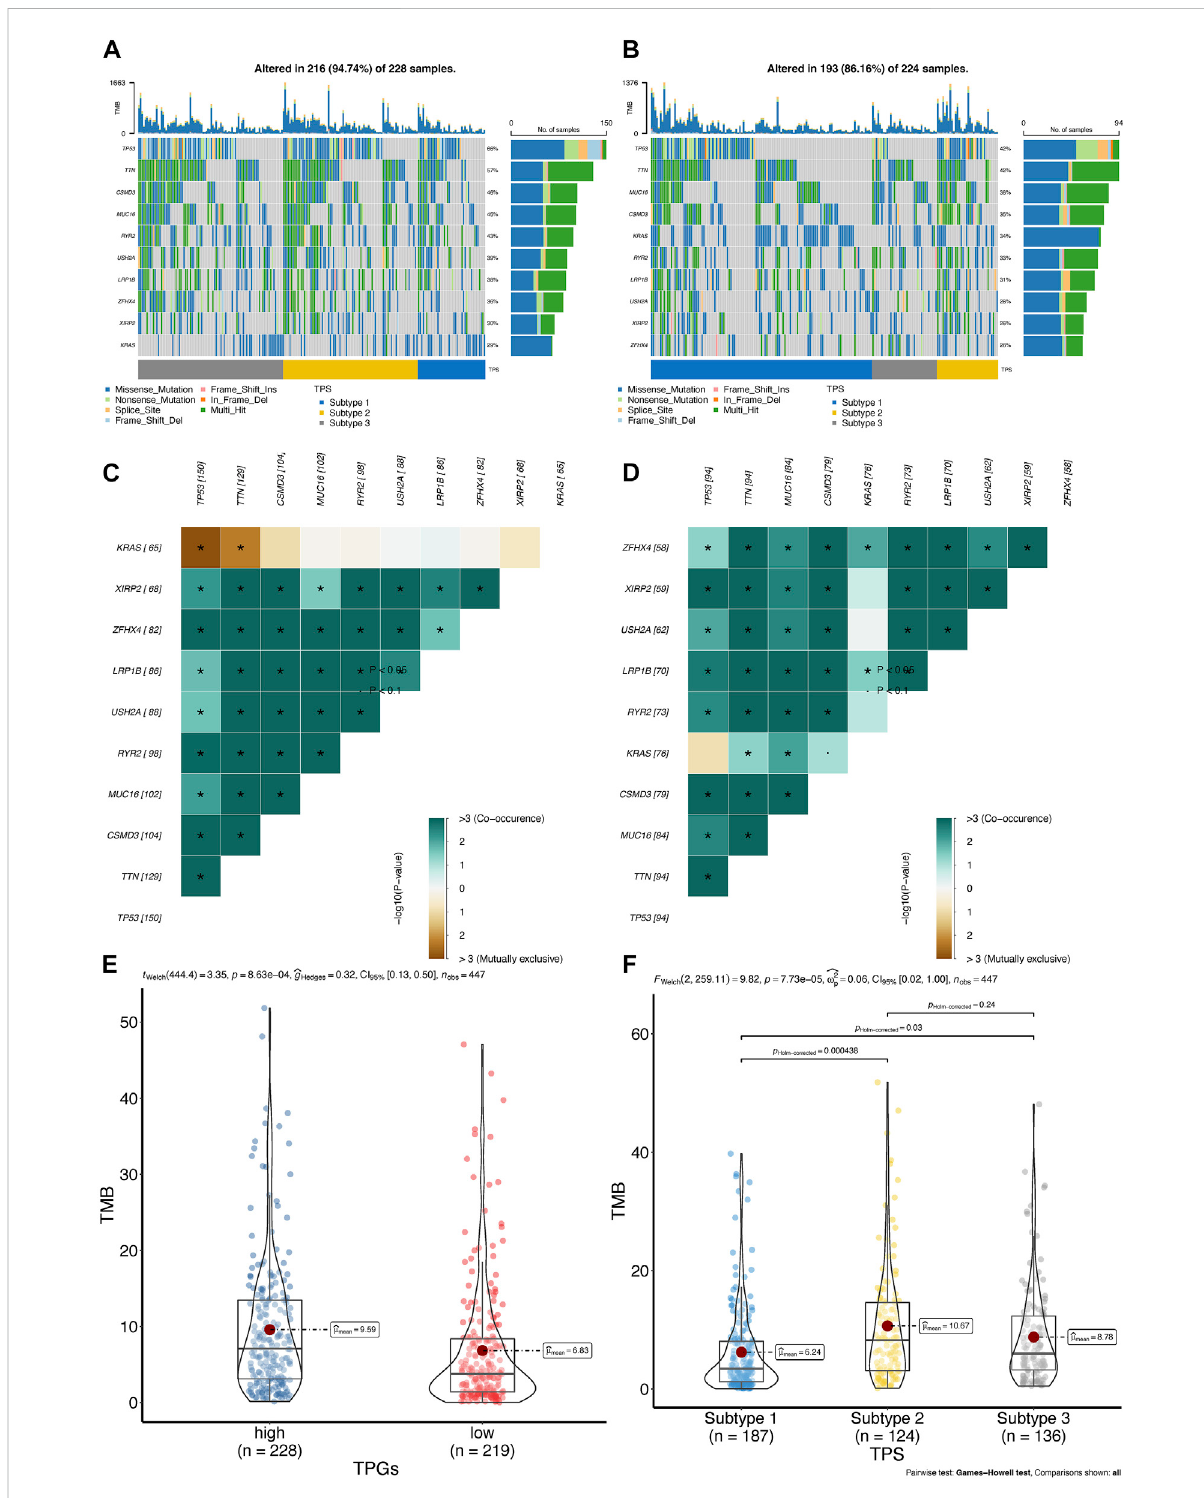
FIGURE 7 The landscape of somatic mutation between high- and low-risk group in TCGA-LUAD cohort. (A,B) Oncoplot of genes with highest counts of variants between high- (A) , n = 250 and low-risk score (B) , n = 250 in TCGA-LUAD cohort. (C,D) Signi fi cant exclusive or co-occurrence top 10 mutation gene sets are indicated in the high-risk score (C) and low-risk score (D) in TCGA-LUAD. (E,F) Distribution of tumor mutation burden in TPR signature (E) and TPC (F) group patients; TMB, tumor mutation